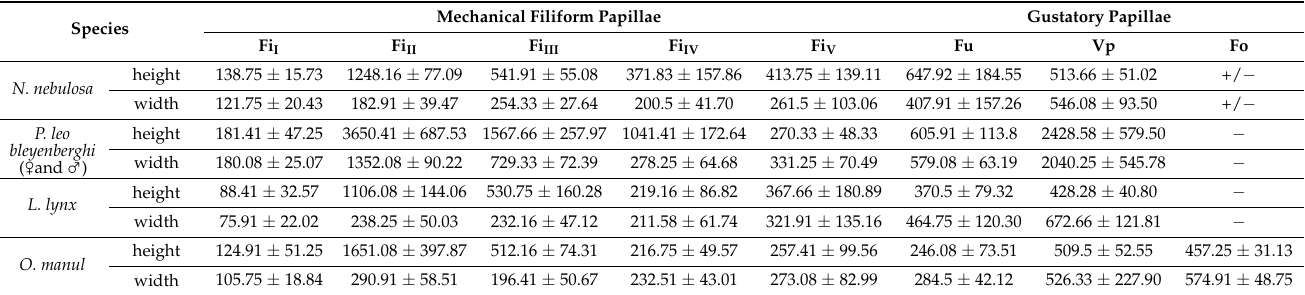
Table 3. Measurement (height and width ( µ m)) of the mechanical filiform papillae and gustatory papillae in the four felid species described in this study.